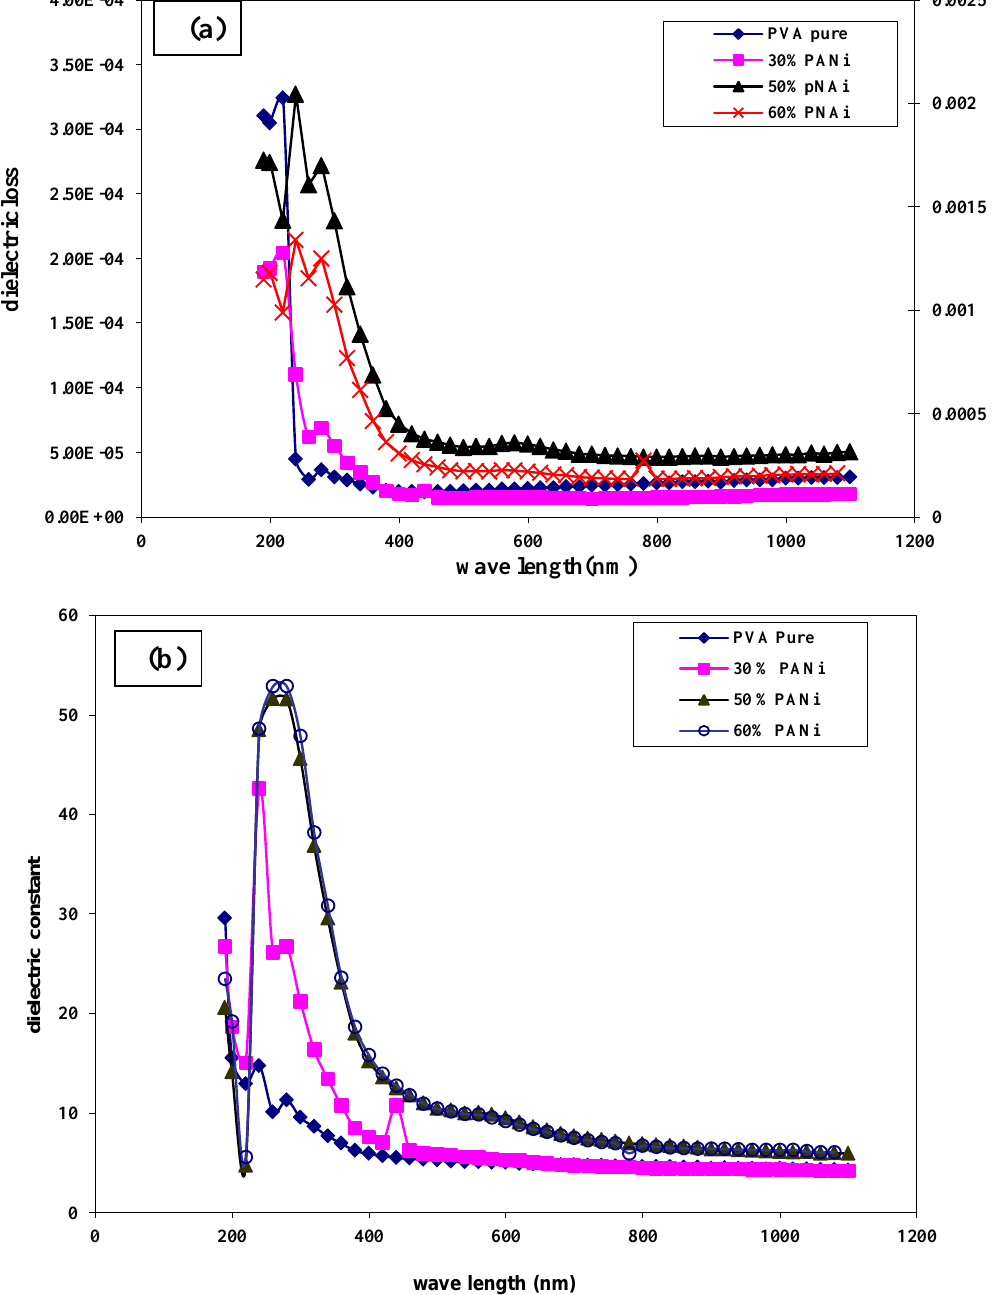
Fig. 6: Dielectric constant, (a) dielectric loss, (b) dielectric constant b vs. wave length (nm) for (PVA +PNAI) blends